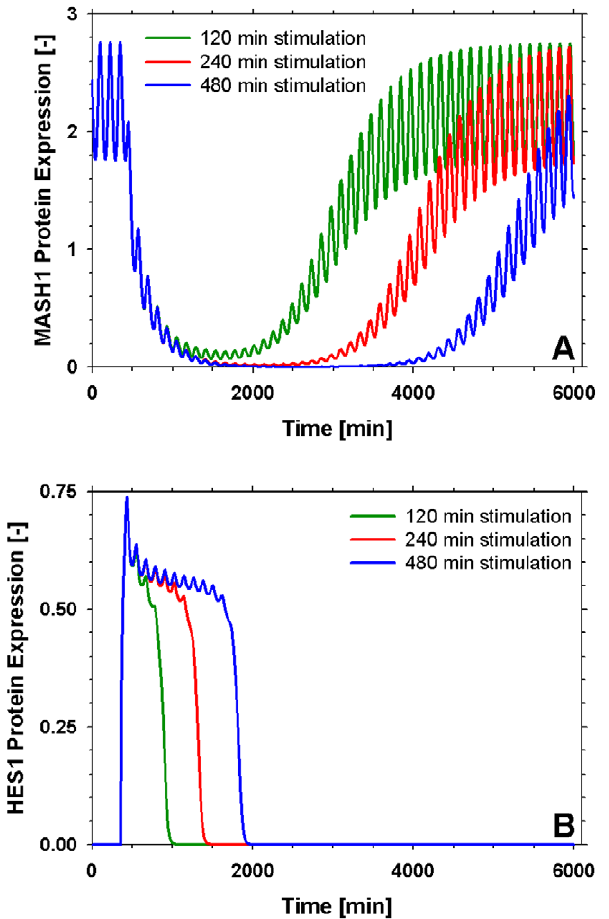
Figure 5. Response to the application of a delta signal for varying time periods. (A) Mash1 and (B) Nicd expression. As the duration of the application of the delta signal increases so does the lag period required for the system to return to its original resting state. The duration of the application of the delta signal has no effect on the maximal NICD concentration.